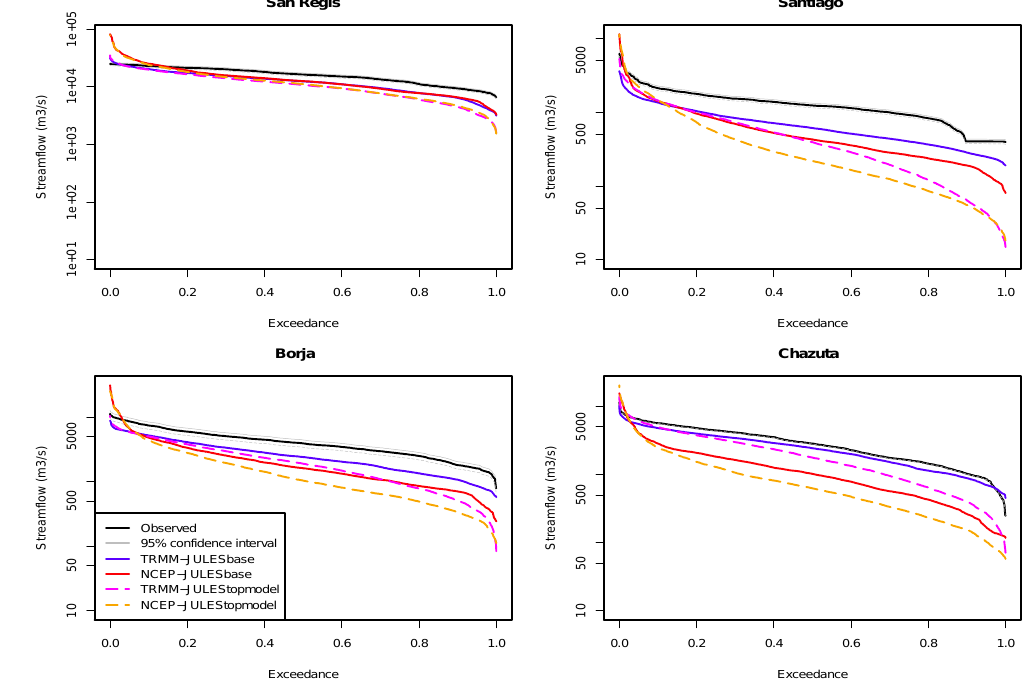
Fig. 6. Comparison of flow duration curves from observed and simulated